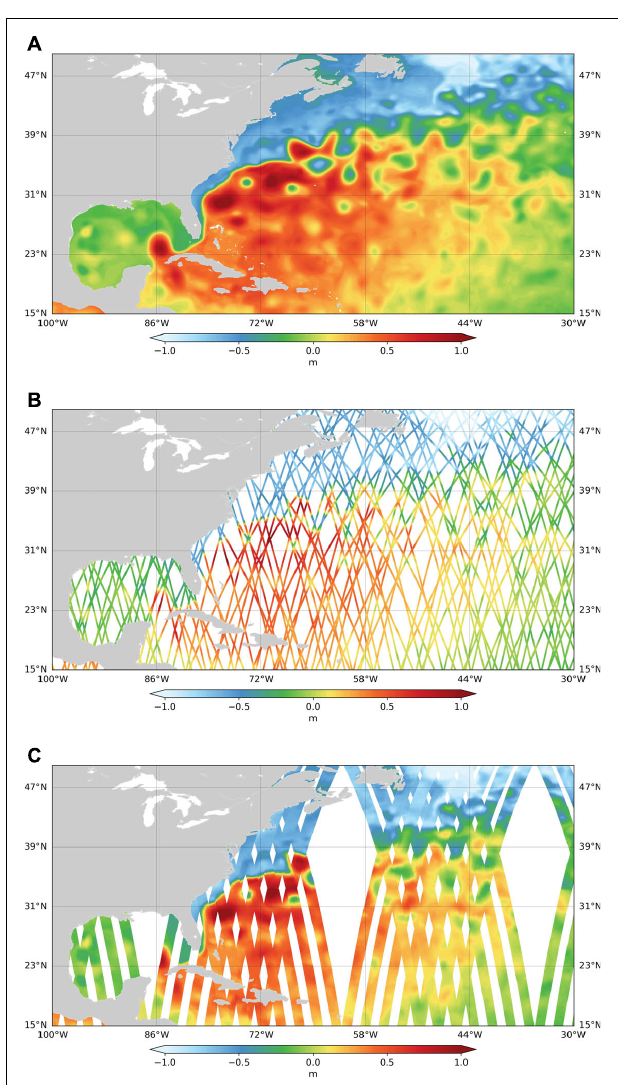
FIGURE 6 | (A) SSH from Truth Run (NR) on January 4, 2015, (B) simulated along-track data from Jason3, Sentinel3A and Sentinel3B for seven days assimilation cycle, and (C) simulated SWOT data